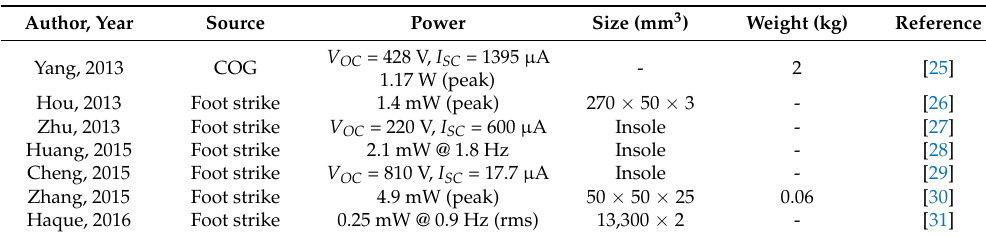
Table 3. Wearable triboelectric energy